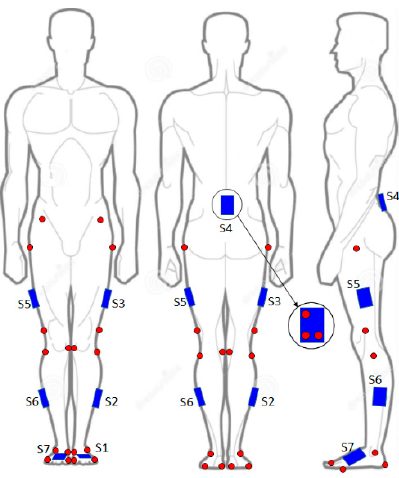
Figure 1. Markers and inertial units’ placement. Each inertial unit was equipped with three markers (red dots).